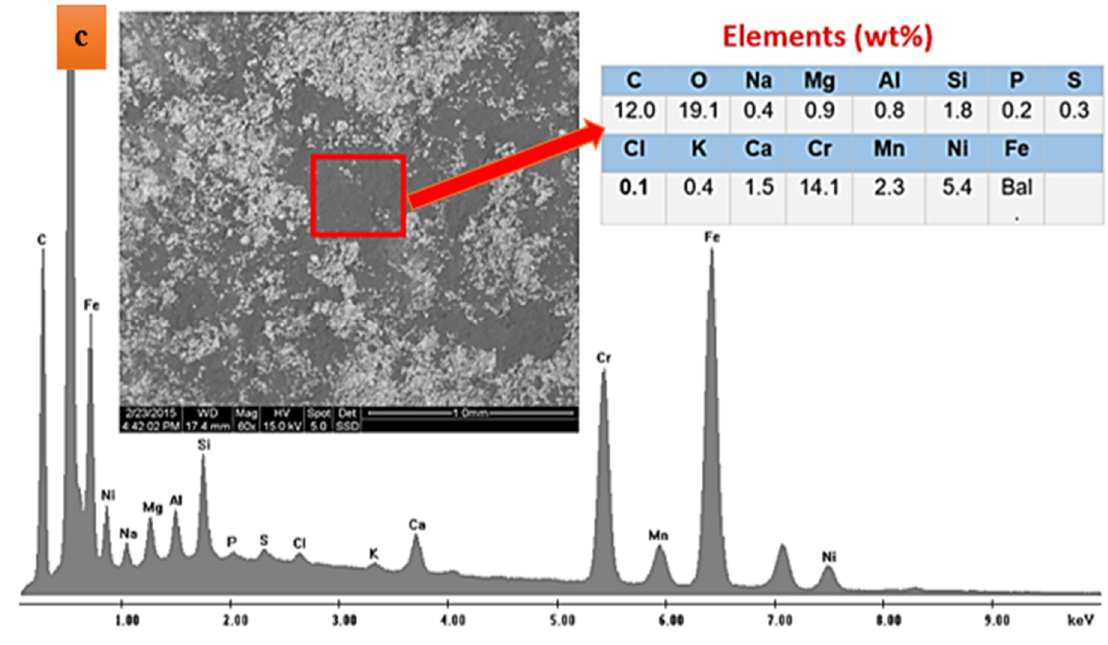
Figure 2. ( a ) Optical microscope image of grain falling-out at the surface, ( b ) SEM image of grain falling-out at the surface, and ( c ) SEM / energy-dispersive X-ray spectroscopy (EDS) analyses of deposits on the surface.